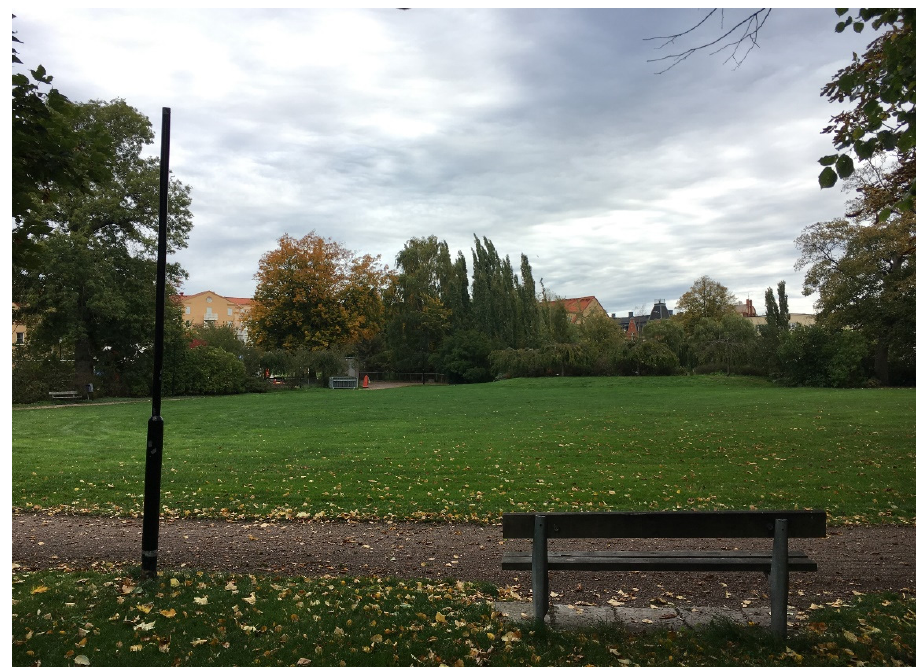
Figure 5. Adolescents wanted to have more activities in the open lawn area.